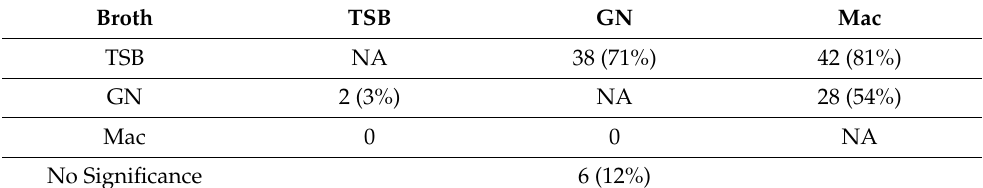
Table 2. Percentage of isolates with significantly different growth in each broth ( n = 52).